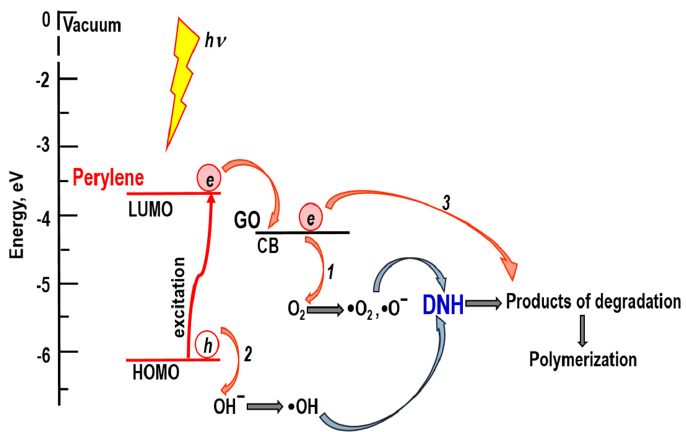
Figure 9. The proposed mechanism of the photoinduced destruction in the GO/Zn (OAc)2/PDI micropores. The conduction band edge (CB ( − 4.33 eV)) for GO and the HOMO energy level ( − 3.6 eV) for PDI are from Reference [53]. For DNH, the HOMO energy level ( − 5.5 eV) and optical bandgap (3.6 eV) for calculation of the LUMO level are from Reference [54].